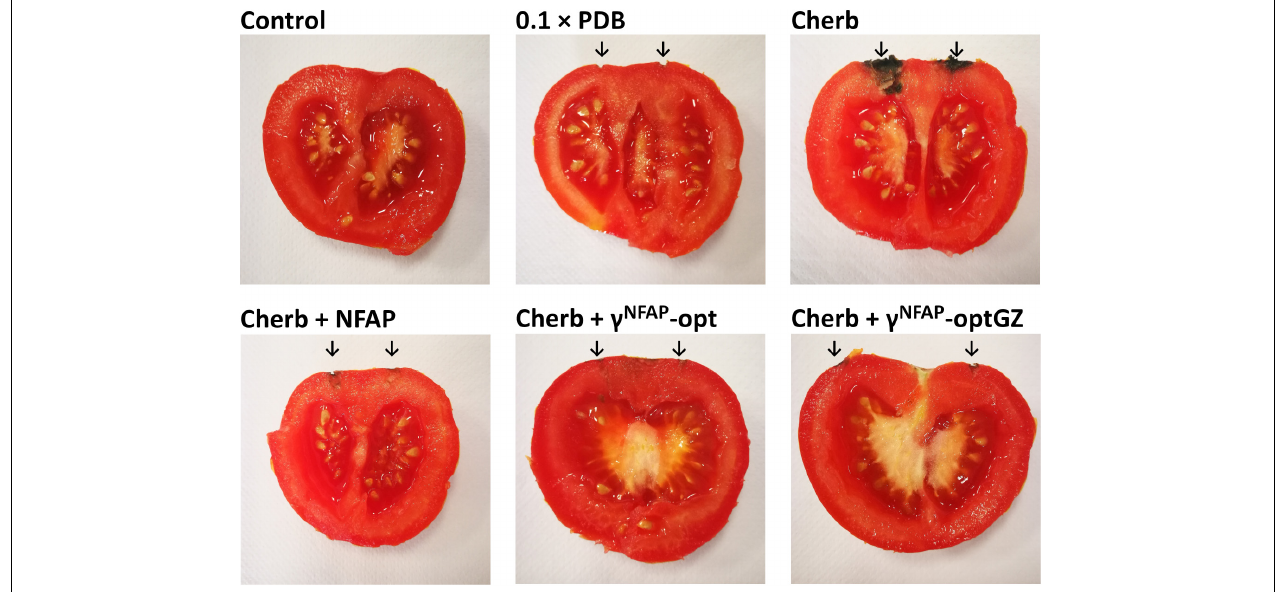
FIGURE 5 | The biopreservation potential of Neosartorya fischeri antifungal protein (NFAP) (Cherb + NFAP) and γ -core peptide derivatives (PDs) (Cherb + γ NFAP -opt, Cherb + γ NFAP -optGZ) of postharvest tomato fruits infected with Cladosporium herbarum FSU 1148 after incubation at 23 ◦ C for 7 days. The controls were uninfected but treated with medium (0.1 × PDB) or infected with C. herbarum FSU 1148 (Cherb) but without AP or PD treatment. Infected tomatoes were treated with 100 µ g ml − 1 NFAP, 12.5 µ g ml − 1 γ NFAP -opt, or γ NFAP -optGZ, respectively. Unwounded tomato fruits without infection and treatment were used as natural decay controls (Control). The sites of the infections and treatments are indicated with the black